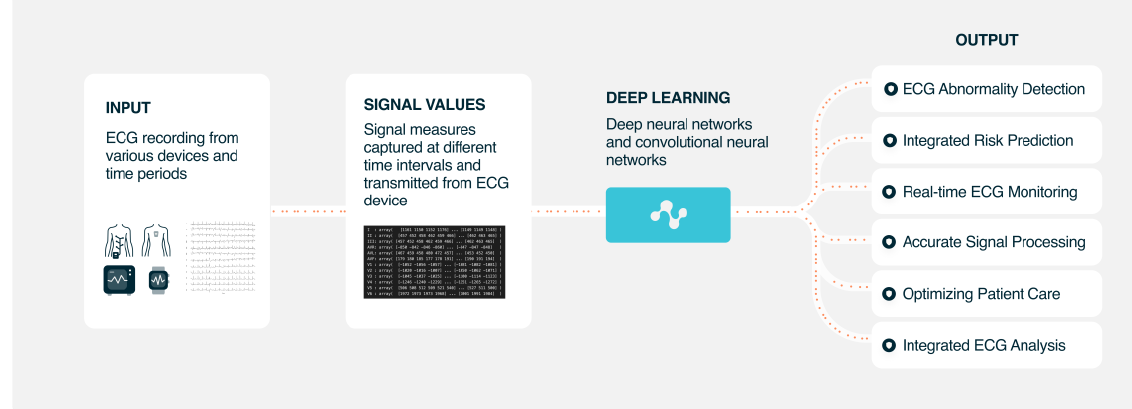
Figure 4. Possible use cases of AI ECG analysis in current clinical workflows.